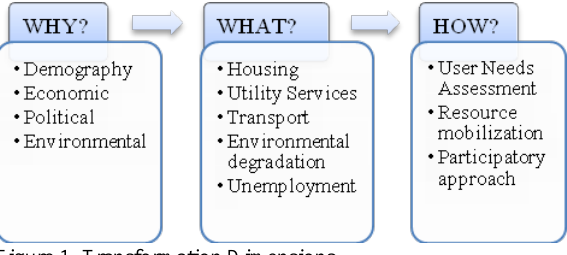
Figure 1. Transformation Dimensions